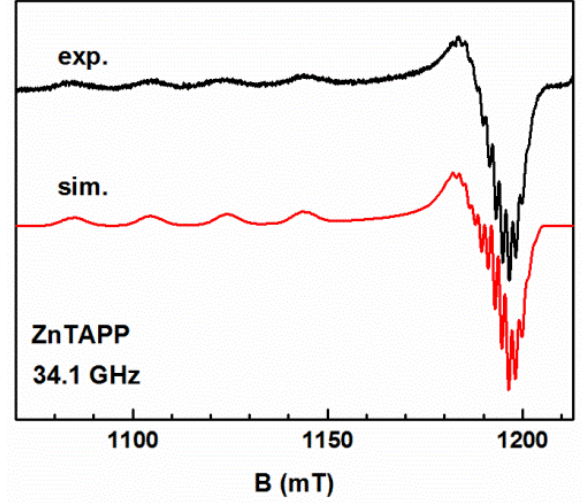
Figure 6. Q-band EPR experimental ( top ) and simulated ( bottom ) spectra of the Cu(II) ions in the ZnTAPP sample.